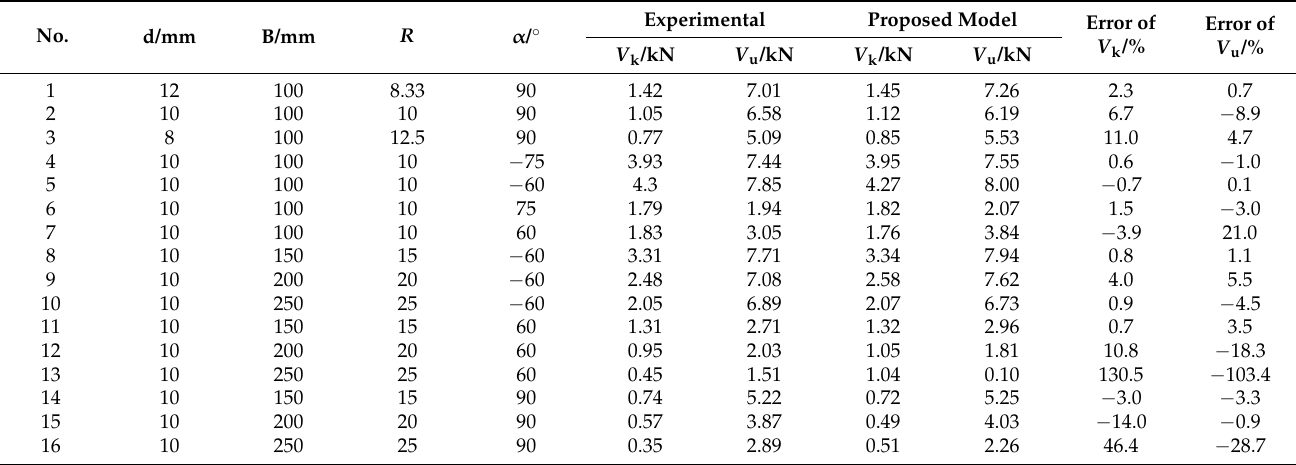
Table 7. Parameters of shear capacity